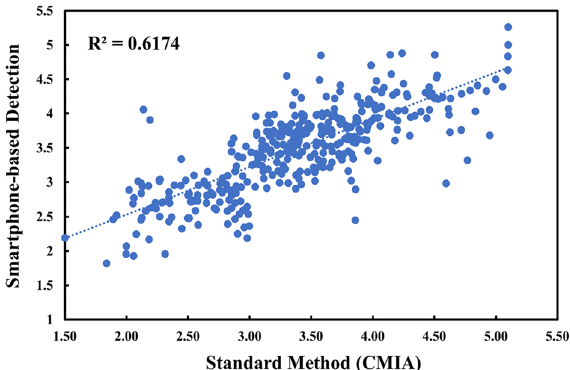
Figure 5. Correlation between HBsAg logarithmic titers obtained from NFC smartphone-based detection and Chemiluminescence microparticle immunoassay